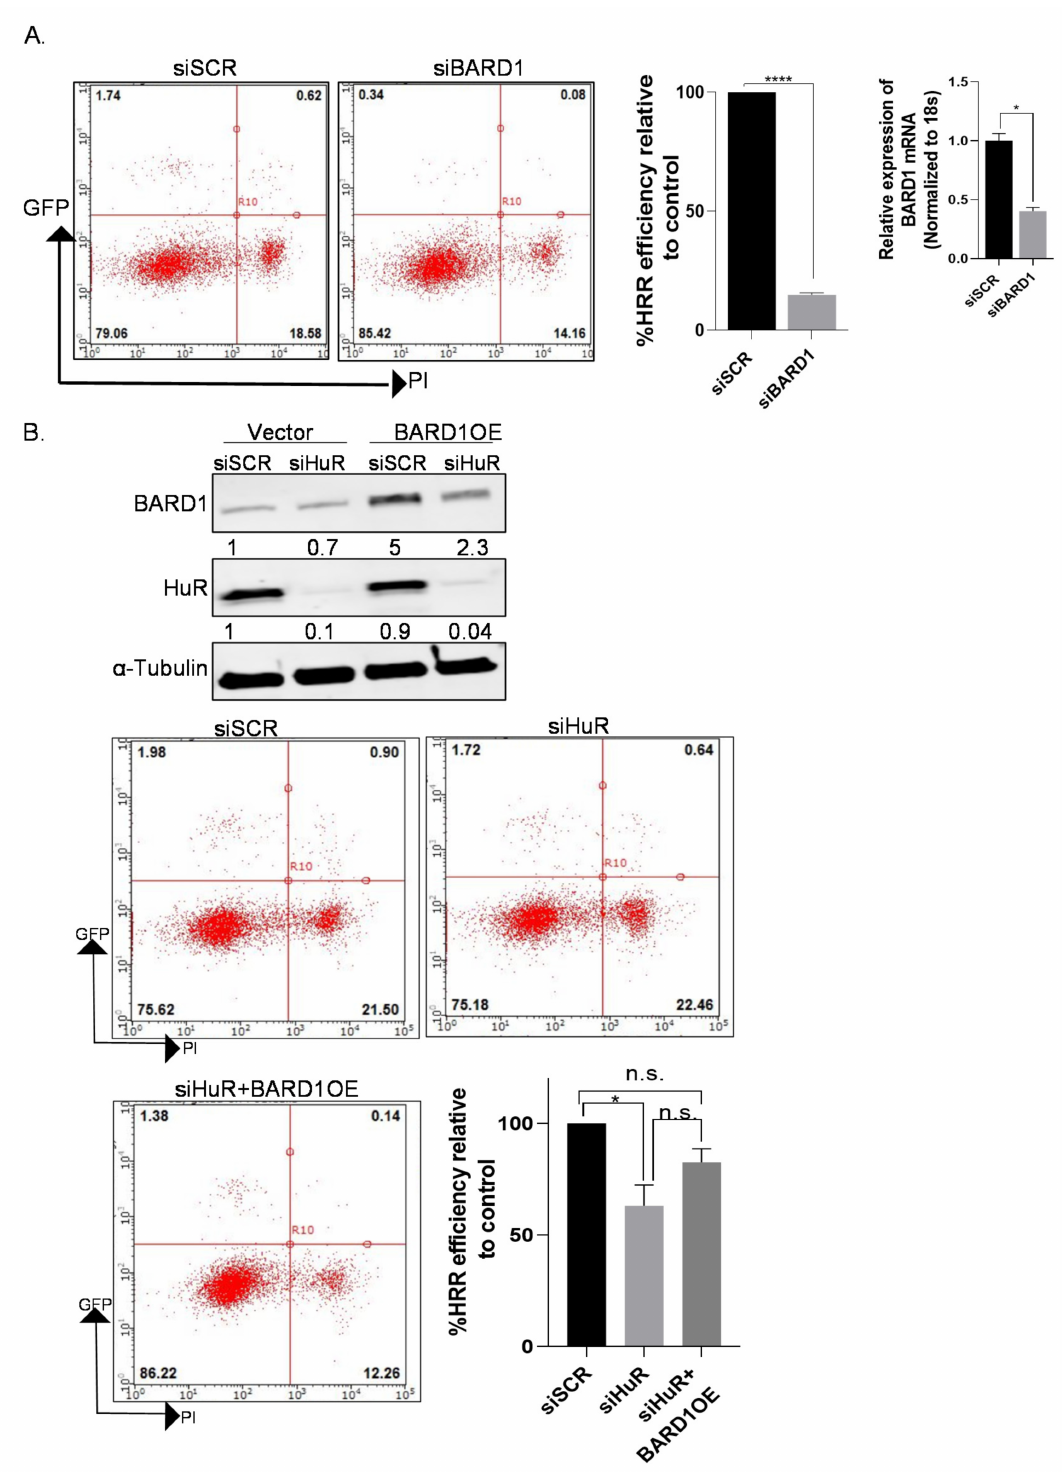
Figure 6. BARD1 partially rescues HuR’s HRR phenotype. ( A ) MiaPaCa-2-DRGFP cells were transfected with siBARD1, and 24 h later, re-transfected with pCBASceI (10 µ g). Graph shows the percentage of HRR efficiency by comparing siSCR and siBARD1 calculated by quantitating GFP- positive cells by flow cytometry. * p < 0.05, **** p < 0.0001 (Student’s t -test). ( B ) pDR-GFP assay, graph, and western blot validation of BARD1-overexpression (BARD1OE) in MiaPaCa-2-DRGFP cells transfected with siHuR. * p < 0.05, n.s.,